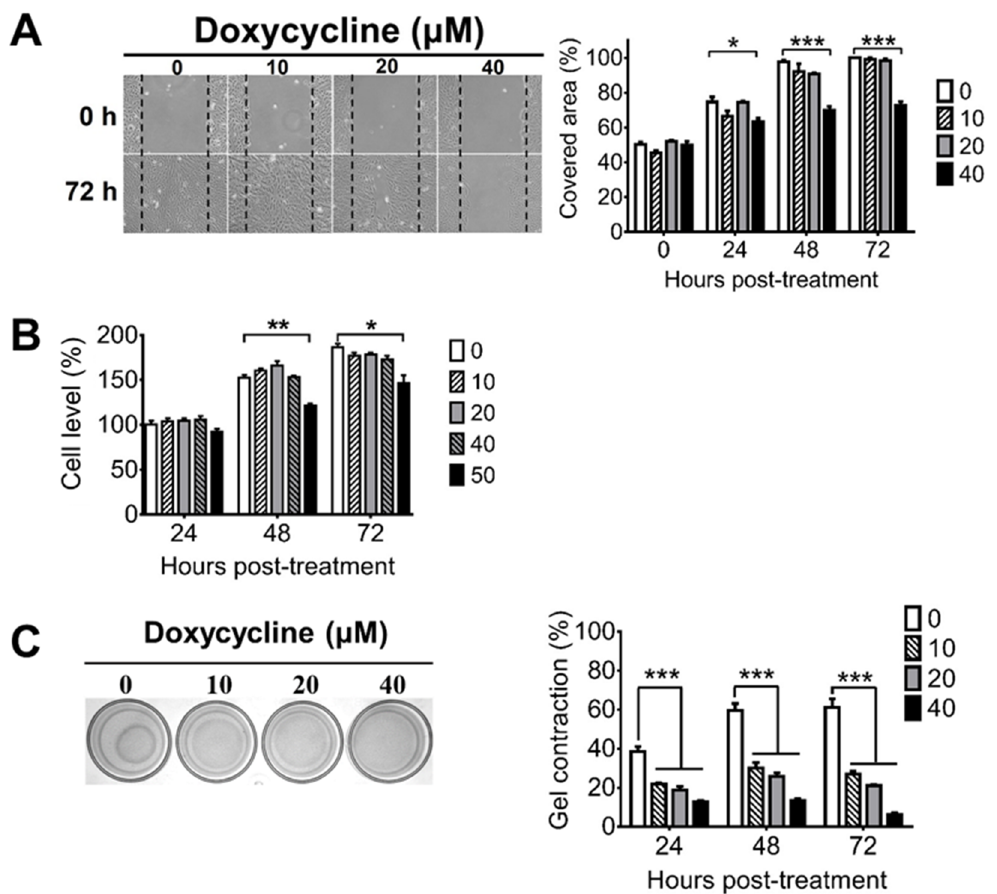
Figure 1. Doxycycline decreases the migration, proliferation, and contraction of ARPE-19 cells. ARPE-19 cells were treated with or without the indicated concentrations of doxycycline and monitored for ( A ) migration, ( B ) proliferation, and ( C ) contraction at the indicated times after drug treatment. The representative samples and quantitated results are shown. The values of ARPE-19 cells without doxycycline treatment for 48 or 24 h are set as 100% in panels A and B, respectively. The data represent means + SEM (error bars) of 3–5 samples per group. Note: *, p < 0.05, **, p < 0.01, and ***, p < 0.001 via Student’s t test. In the left panel of C, 72 h samples are shown.